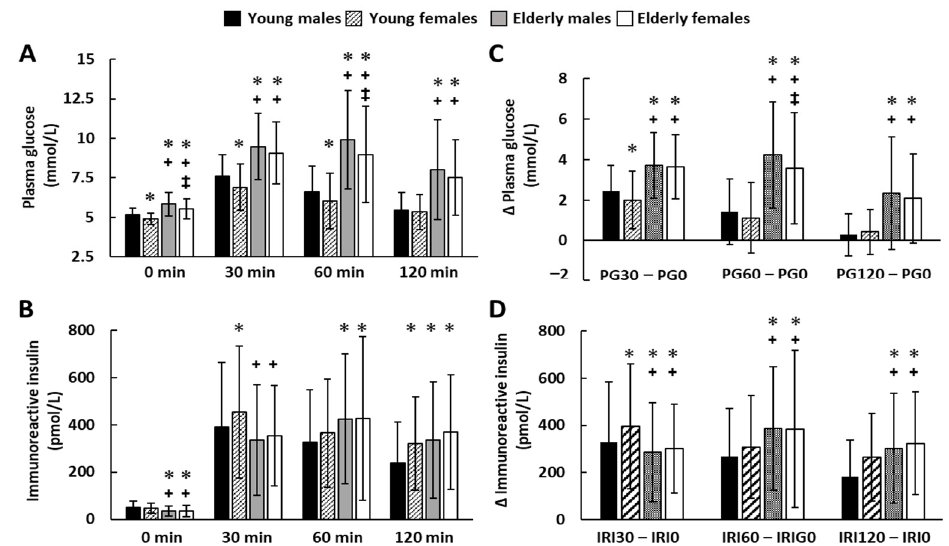
Figure 2. The result of 75 g oral glucose tolerance test in 505 males, 280 females, 127 middle-aged males, and 244 middle-aged females. Sequential changes in plasma glucose ( A ) and insulin ( B ) concentration in each group during 75 g oral glucose tolerance test. Differences of plasma glucose ( C ) and insulin ( D ) concentration from pre-load time in each group during 75 g oral glucose tolerance test. Data are presented as means ± SD. * p < 0.05 versus young males; + , p < 0.05 versus young females; ‡ , p < 0.05 versus elderly males, at the same time. PG0, preload plasma glucose; PG30, 30 min postload